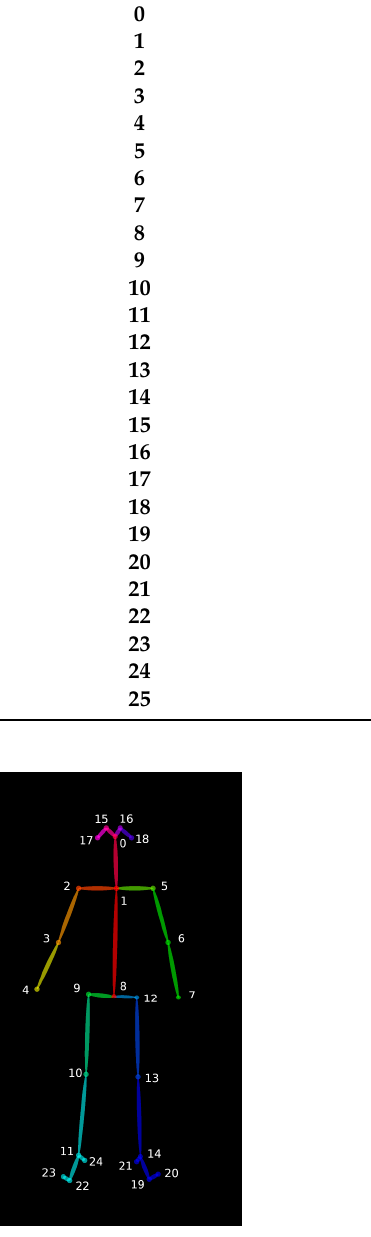
Figure A1. OpenPose Body_25 keypoint model. Adapted from OpenPose GitHub repository [https://github.com/CMU-Perceptual-Computing-Lab/openpose/blob/master/doc/out- put.md#pose-output-format, accessed on 15 July